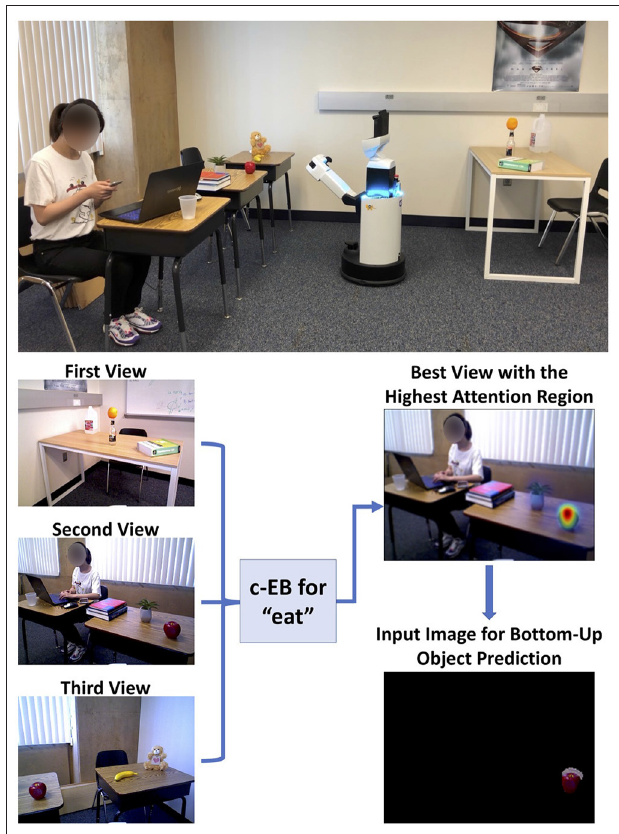
FIGURE 7 | Toyota Human Support Robot implementation for the goal-driven perception model, including the top-down attentional search process for a guessed action “eat” based on three different real indoor views, to select the highest attention region for bottom-up object prediction. Adapted from Zou et al.